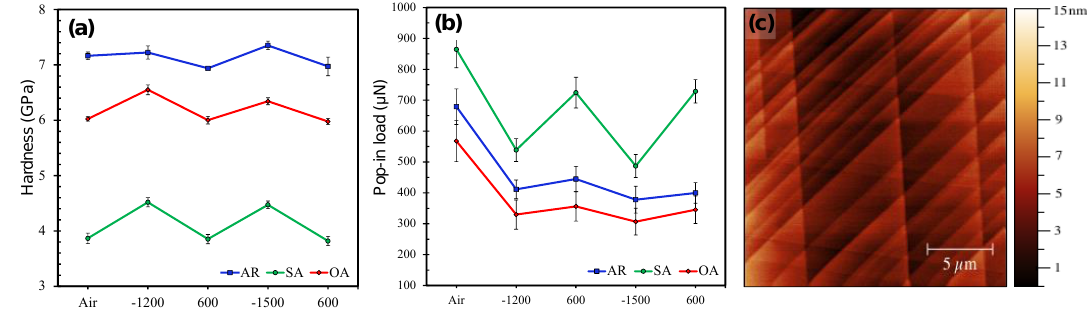
Figure 3. Averaged ( a ) hardness and ( b ) pop-in load values for the three heat treated samples in air and under different applied potentials obtained by nanoindentation. ( c ) Surface topography of the SA sample after exposure to − 1500mV for